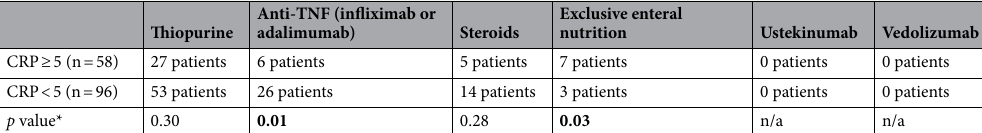
Table 2. Medication usage between inflamed and uninflamed patient groups. Significant values are in [bold]. Patient were frequently on multiple therapies. Twenty-seven patients were on no medications, or only nutritional therapy, at the time of plasma sampling. *Calculated using a χ 2 test.